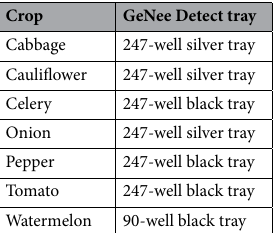
Table 1. GeNee Detect trays used for seed capturing per crop in this study.